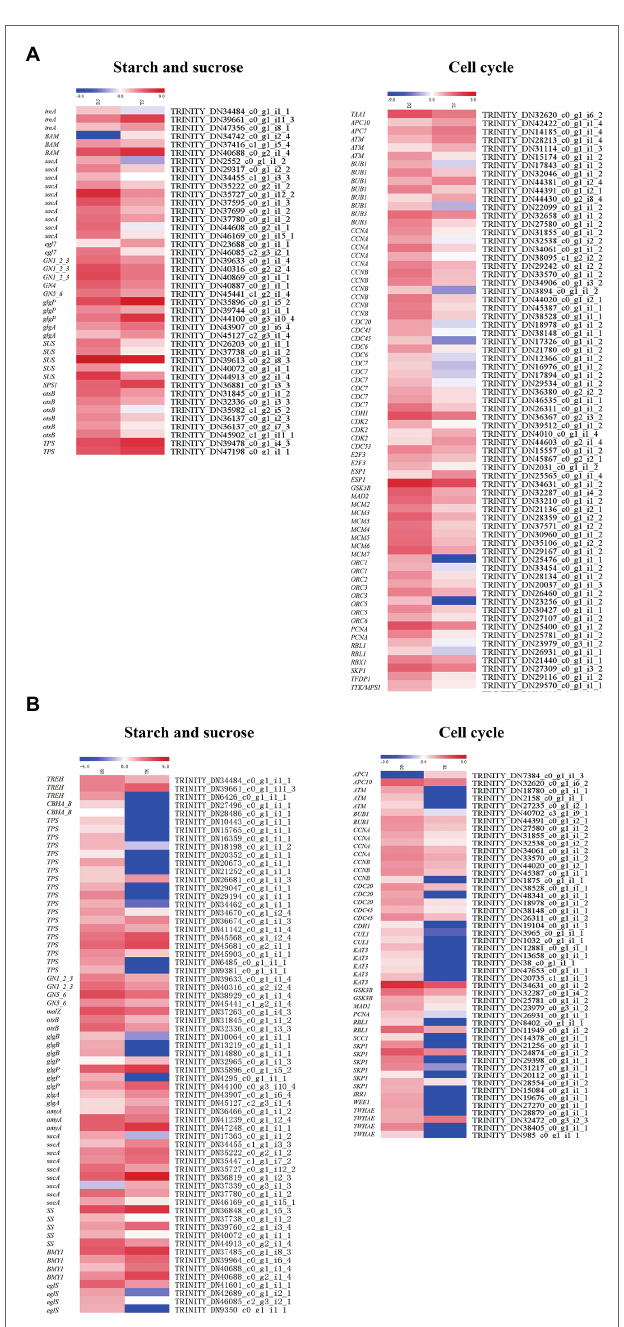
FIGURE 8 | Heat maps depicting DEGs involved in starch and sucrose biosynthesis and metabolism and cell cycles: (A) shoots, (B)